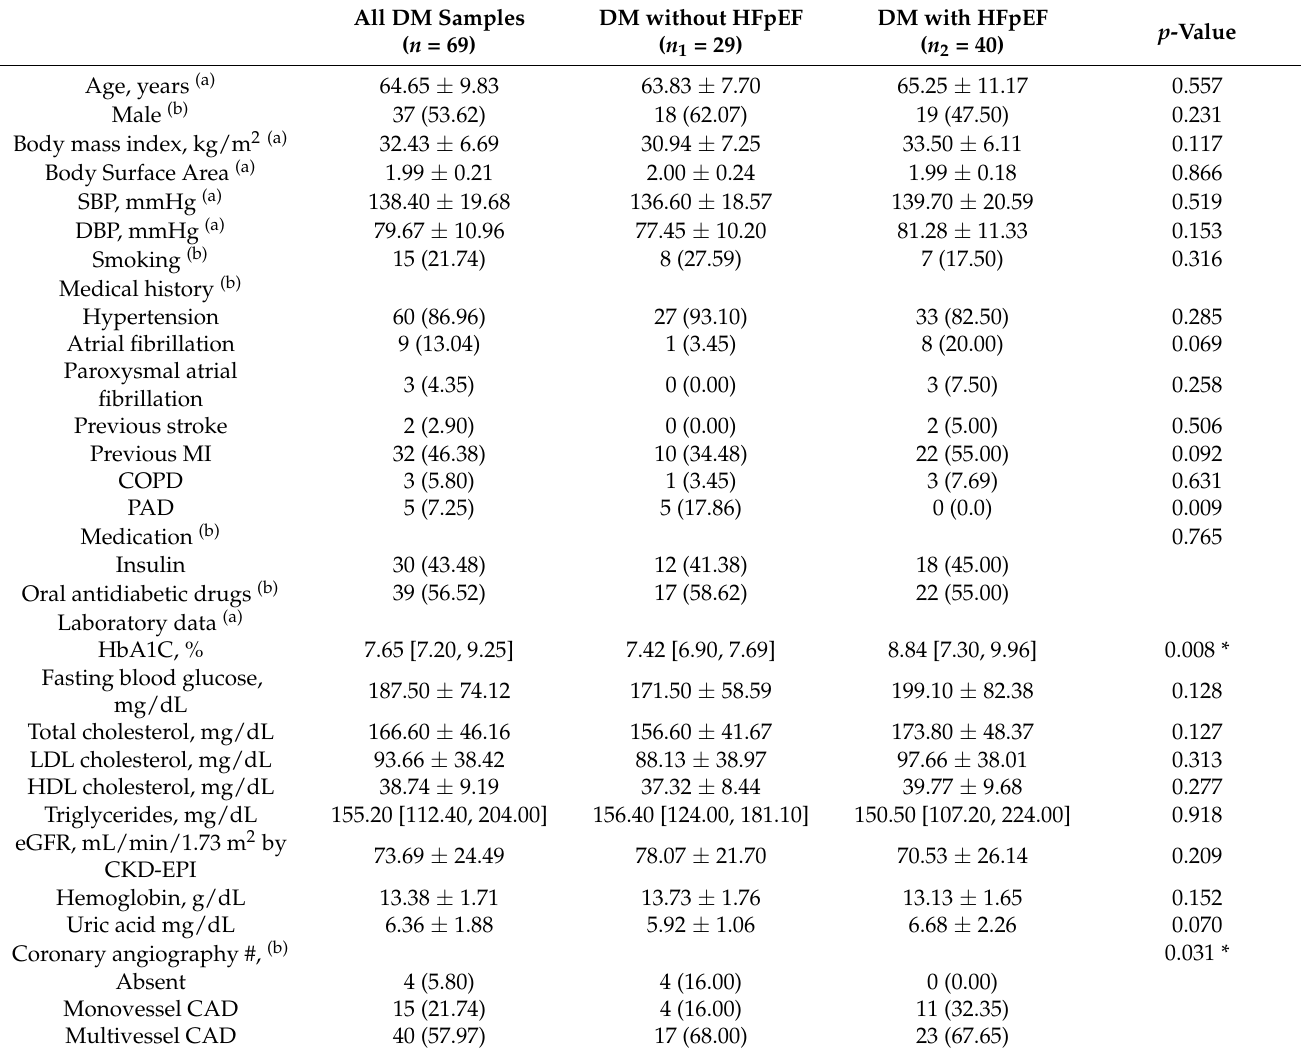
Table 1. Demographic, clinical and para-clinical characteristics of patients with type 2 DM. All DM